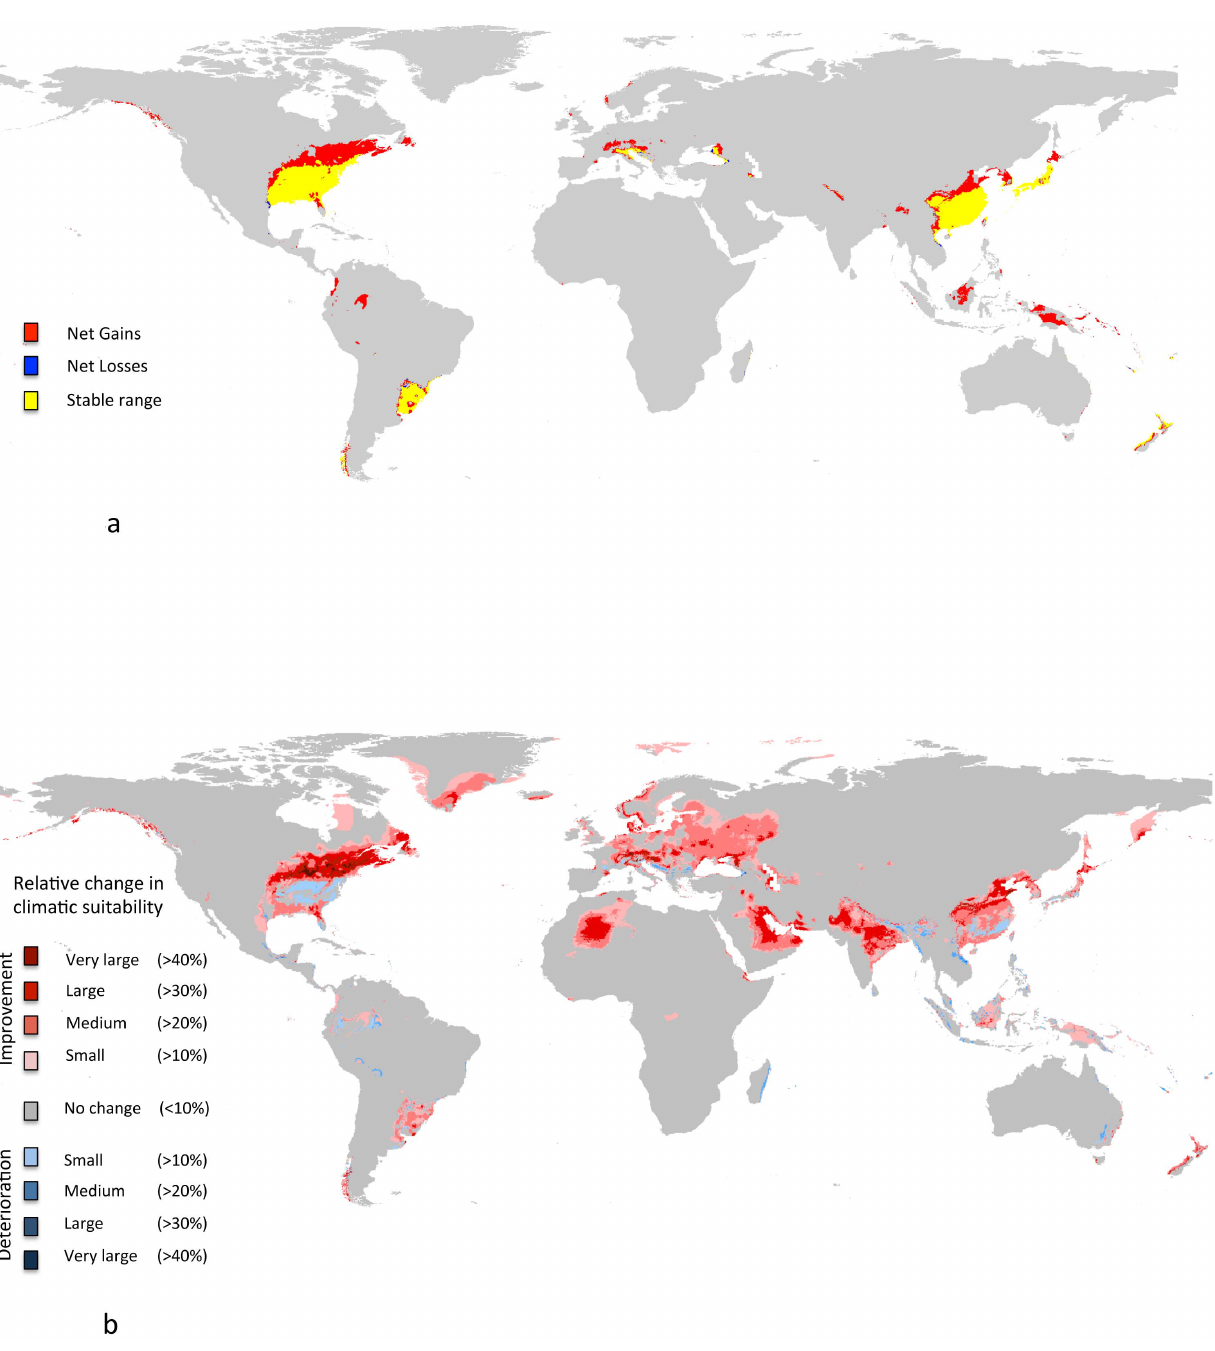
Figure 4. Differences in suitable climatic conditions between the current climate and the consensus projection in 2080. (a) Net gains (red), losses (blue) and stable range (yellow), (b) Relative differences in suitability : red colors indicate improved climatic suitability (light to dark red gradient indicates the relative change in suitability), blue colors indicate deteriorated climatic suitability for P. chinensis.